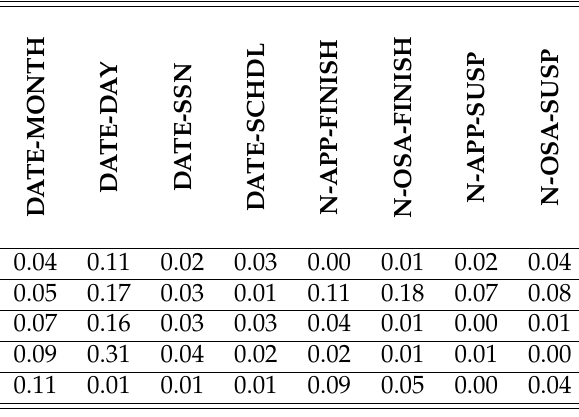
Table 8: Extract from the prepared data and formatted to decimal values